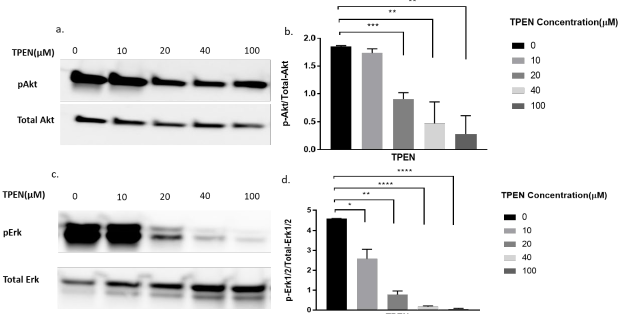
Figure 5. Western blot result of pAkt and pErk expression in C2C12 cells treated with increasing concentrations of TPEN. ( a , c ). Cells were treated with increasing concentrations of TPEN (0, 10, 20, 40, 100 µM) for 60 min followed by 30 min of 20 µM zinc,10 µM NaPy and 10nM insulin treatment before harvesting total protein. Phosphorylated Akt and Erk were immunoprobed by Western blotting. Total Akt and Total Erk were used as internal controls. Three independent Western blots on three independent treatments were performed. ( b , d ). Densitometry graphs for pAkt and pErk, respectively, from three independent data Western blots * = p < 0.05, ** = p < 0.01, *** = p < 0.001, **** = p <